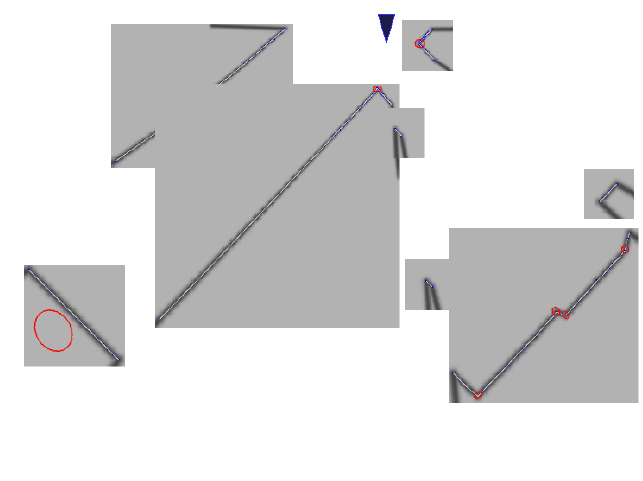
Figure 3. Intel Research Center rasterization. This indoor dataset has many rectilinear features. Rendering is performed for each contour individually as illustrated by the black rectangular outlines; this dramatically reduces computation time. Ellipses indicate 3 σ uncertainty bounds for detected features. At the occlusion boundaries of each contour, the conservatively extrapolated contour is readily